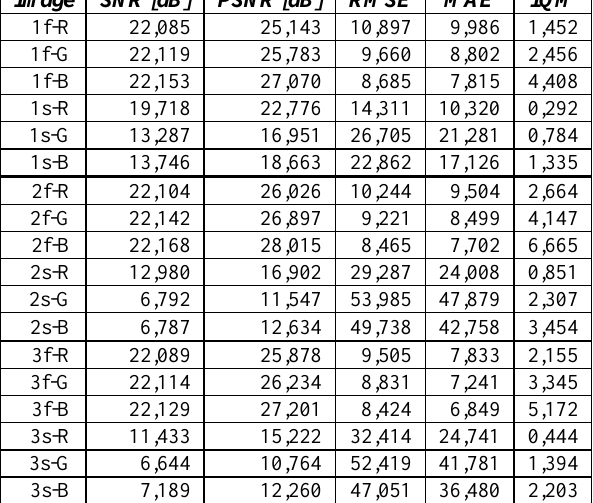
Table 2. The values of image quality for its channels (RGB)